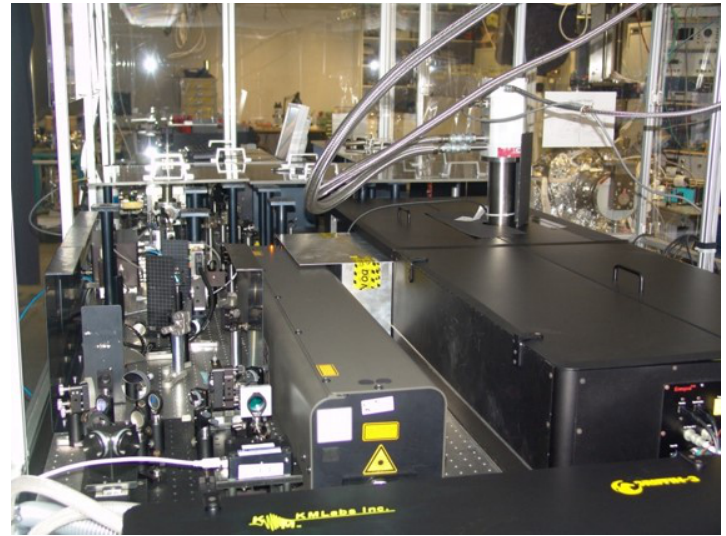
Figure 9: Multi-pass laser amplifier (KMLabs) providing 2 mJ pulse energy at 3 kHz forms the core of the Ju SPARC_DENEB laser system commissioned for spin dynamics experiments in thin magnetic films and multilayers.